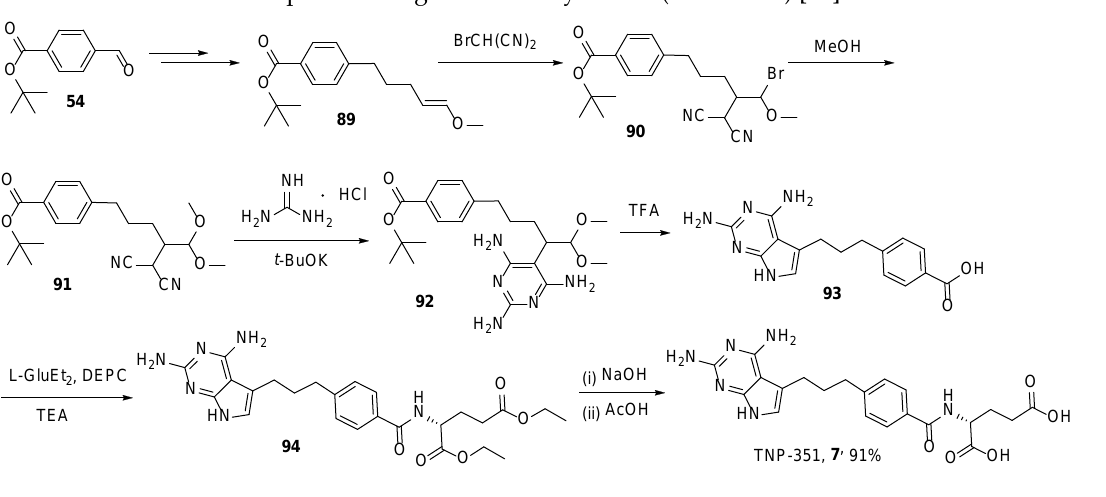
Scheme 28. Multistep synthesis of TNP-351.